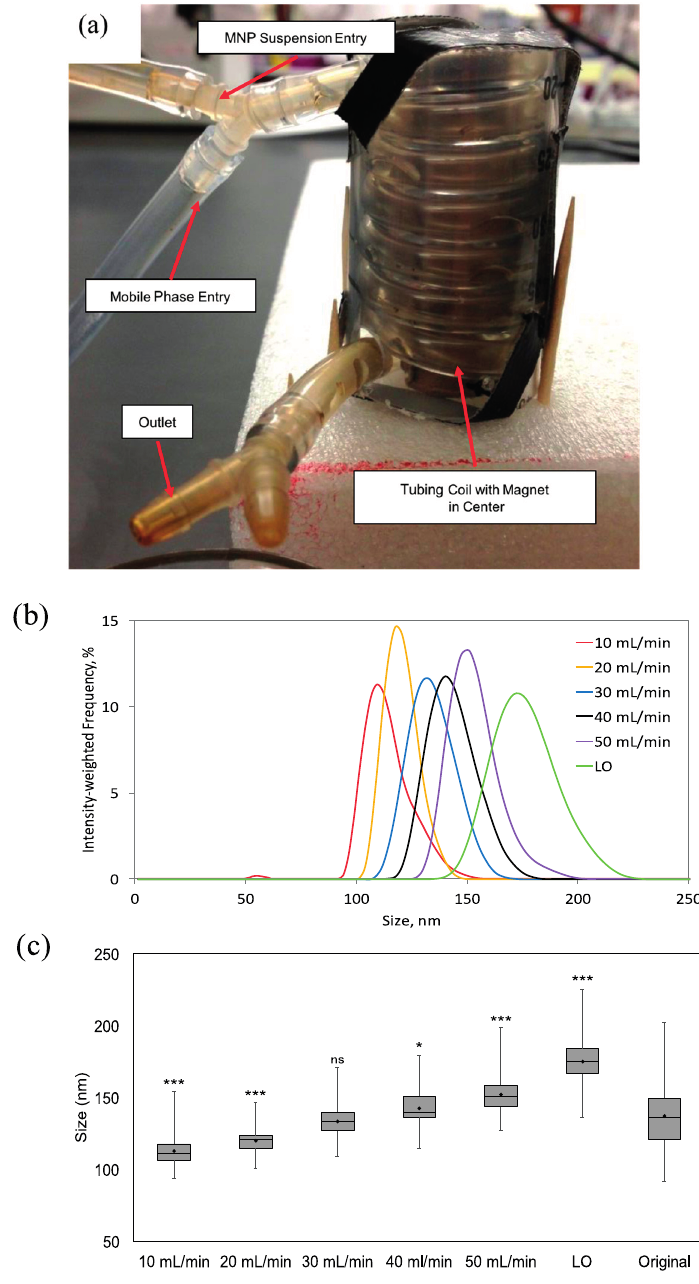
Figure 4. ( a ) Digital image of MagCoil magnetic separation prototype composed of 1/8 ′′ I.D. tubing wrapped around the length of a 2 ′′ diametrically magnetized cylinder encased in a plastic column for stability; ( b ) Average size distributions obtained using the MagCoil prototype and flow rates of 10, 20, 30, 40, and 50 mL/min, as well as the flushed particles (LO) calculated from the results of three separate experimental runs; ( c ) Box-and-whisker plot comparing the size distributions obtained using the MagCoil, at the varying flowrates, to the original size distribution. Horizontal lines indicate the mean diameter (nm), while the bar indicates standard deviation, and the vertical line the range. Significance determined using a two-tailed, two sample t -test ( n = 90; *** p < 0.001; * p < 0.05; ns—not significant). The large sampling size of DLS (>100 k particle counts/s) leads to a statistically significant result between samples that would seem to be identical